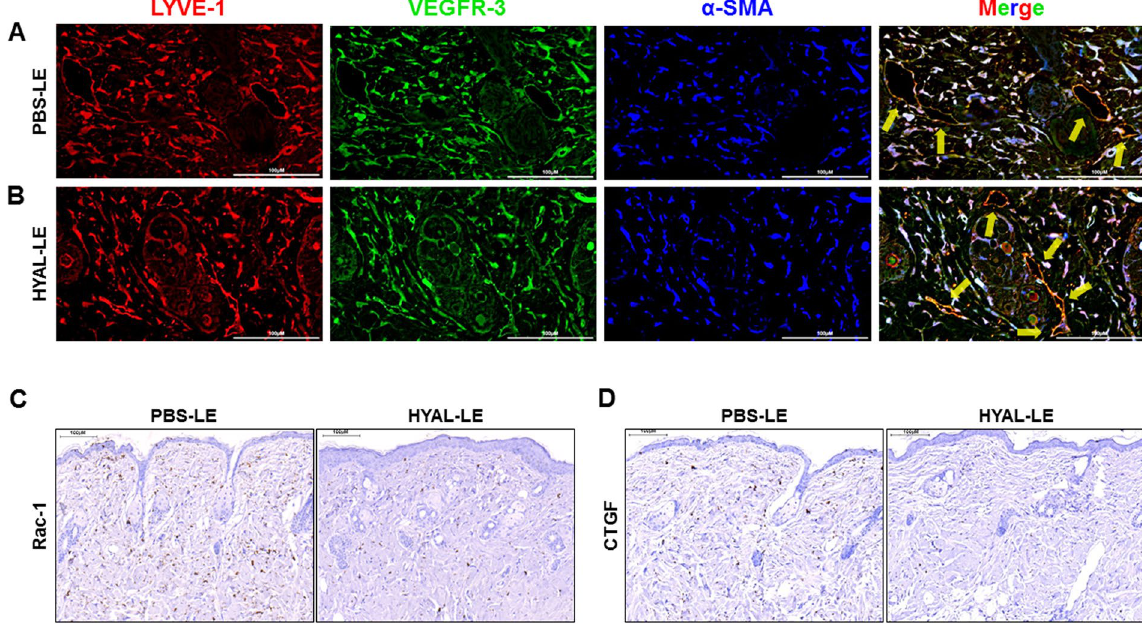
Figure 3. Hyaluronidase treatment restores dilated lymphatic vessels to round lymphatic vessels and downregulates the expression of fibrosis markers. Histological analysis of the effects of hyaluronidase on fibrosis in lymphedema. ( A,B ) Immunofluorescence staining of LYVE-1, VEGFR-3, and alpha-smooth muscle actin in proximal mouse leg sections. Scale bar = 100 μ m. Regions of LTVE-1 and VEGFR-3 colocalization in the lymphatic vessels are marked with yellow arrows. ( C,D ) Immunohistochemistry analysis of RAC1 and CTGF in the dermis layer of the mouse leg. Scale bar = 500 μ m.